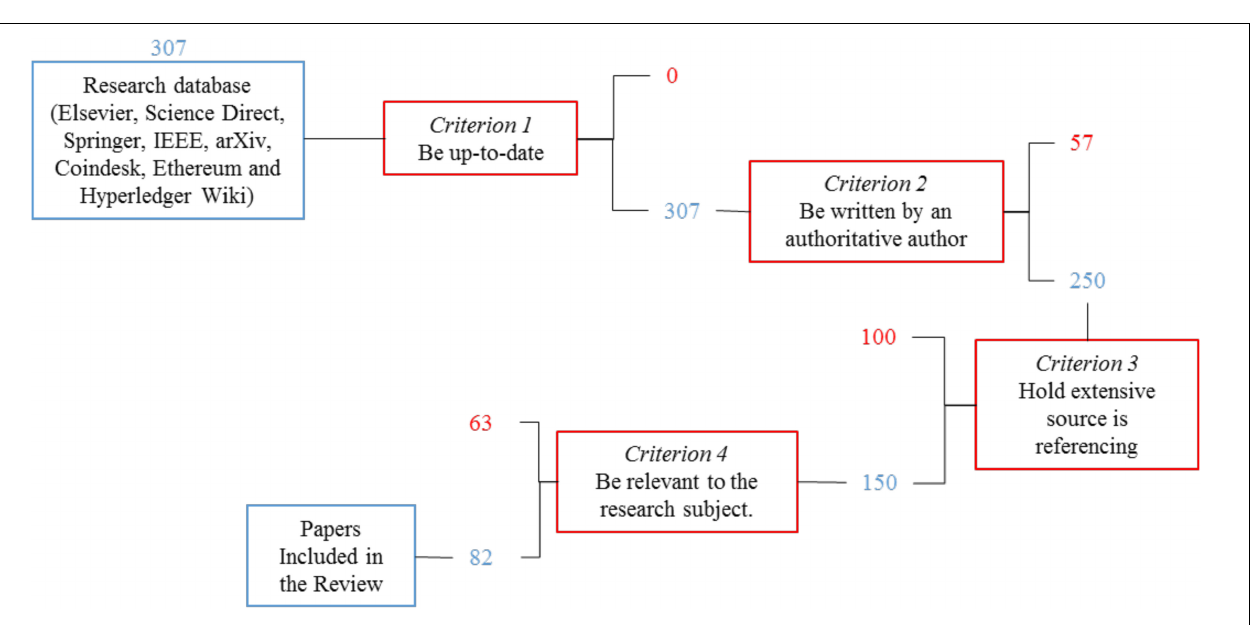
(proof of work), and Shared and Public (provenance of